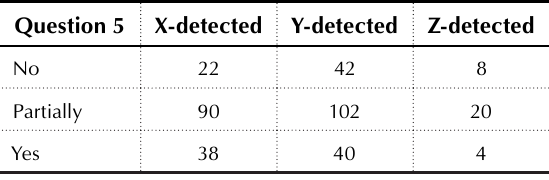
Table 9. The obtained data